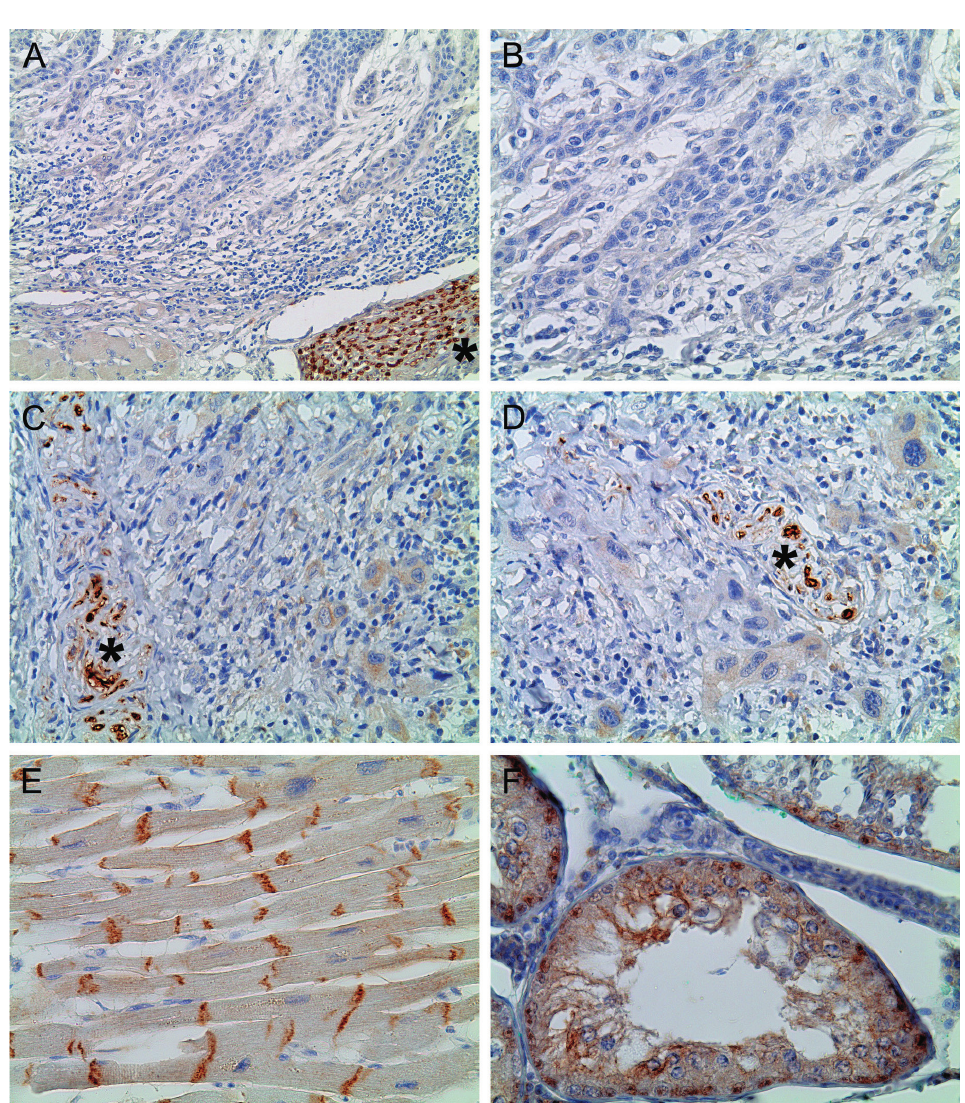
Figure 2- Immunohistochemical reactivity for N-cadherin in oral squamous cell carcinoma (OSCC), normal cardiac striated muscle and normal testis. In OSCC, immunostaining of peripheral nerve bundles in the tumor stroma (marked with asterisk) were used as internal positive controls for N-cadherin. A and B: OSCC exhibiting negative N-cadherin expression (A, X200; B, X400); C and D: OSCC showing inconspicuous N-cadherin expression (C, X400; D, X400); E: normal cardiac striated muscle (N-cadherin positive control) exhibiting positive N-cadherin immunostaining in the intercalated disc (E, X400); F: normal testis (N-cadherin positive control) showing cytoplasmic and membranous N-cadherin immunostaining (E,